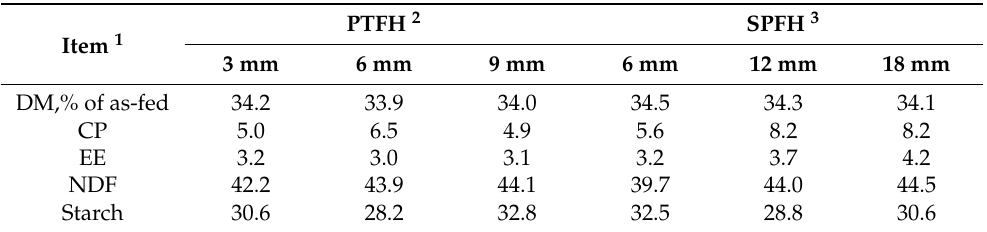
Table 1. Chemical composition of unfermented whole-plant corn harvested with different forage harvesters at different theoretical lengths of cut settings.